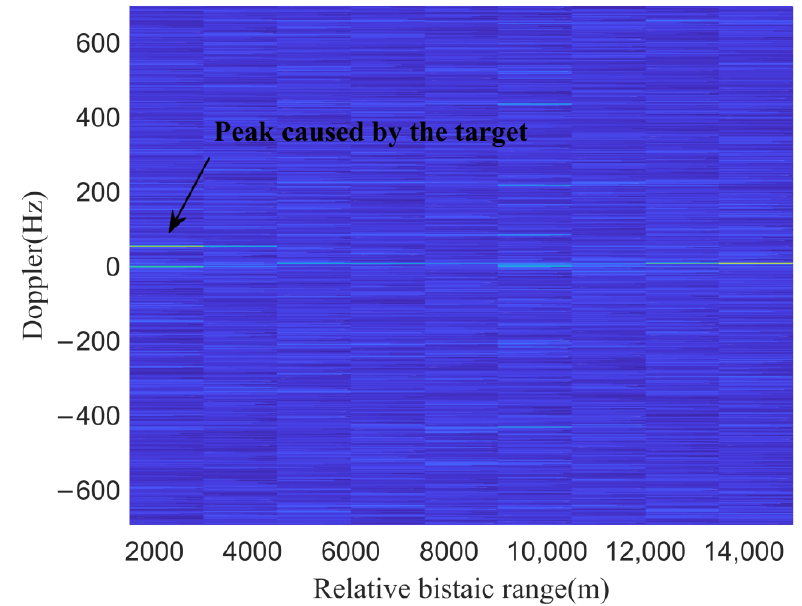
Figure 19. RDCC after eliminating the strongest interference in Figure 18. In Figure 19, the strongest co-channel interferences in the zero-range Doppler unit that appeared in Figure 17 are eliminated and it can be seen that a weak target echo is